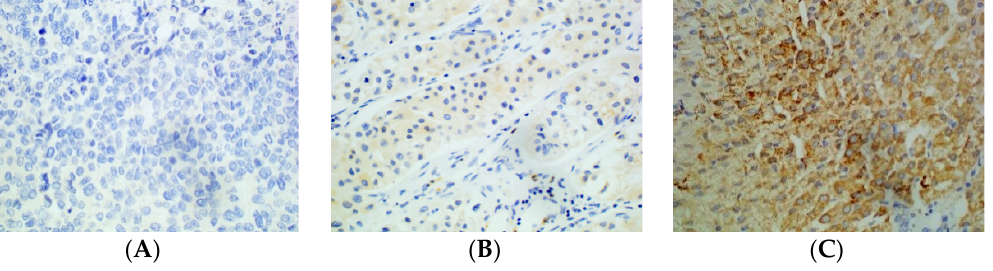
Figure 3. Immunohistochemical staining of HCC tissue using anti-PD-L2 antibody. ( A ): Negative. ( B ): Weakly positive. ( C ): Strongly positive (×400).